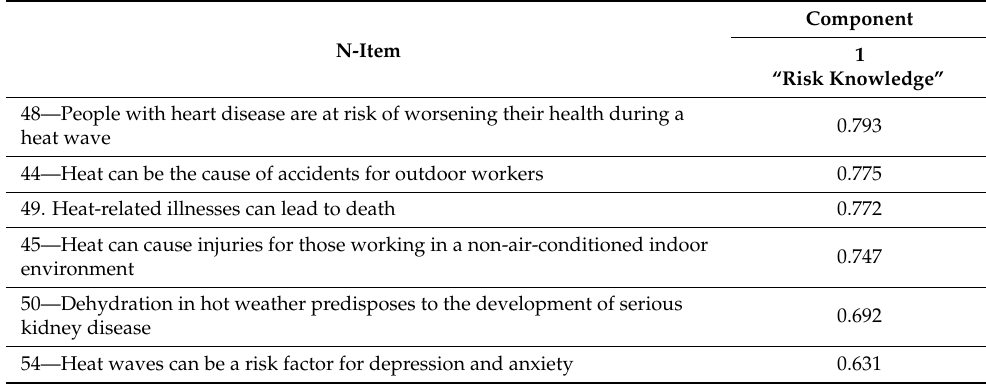
Table 3. Principal Component Analysis of section “Risk knowledge”. Extraction method: Principal Component